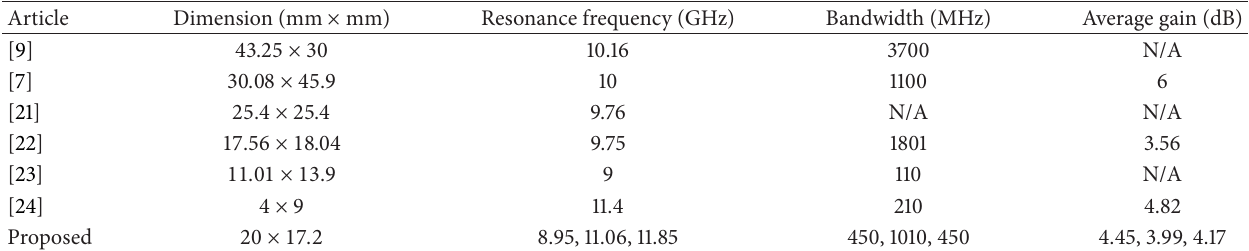
Table 2: Comparison between the proposed and some existing